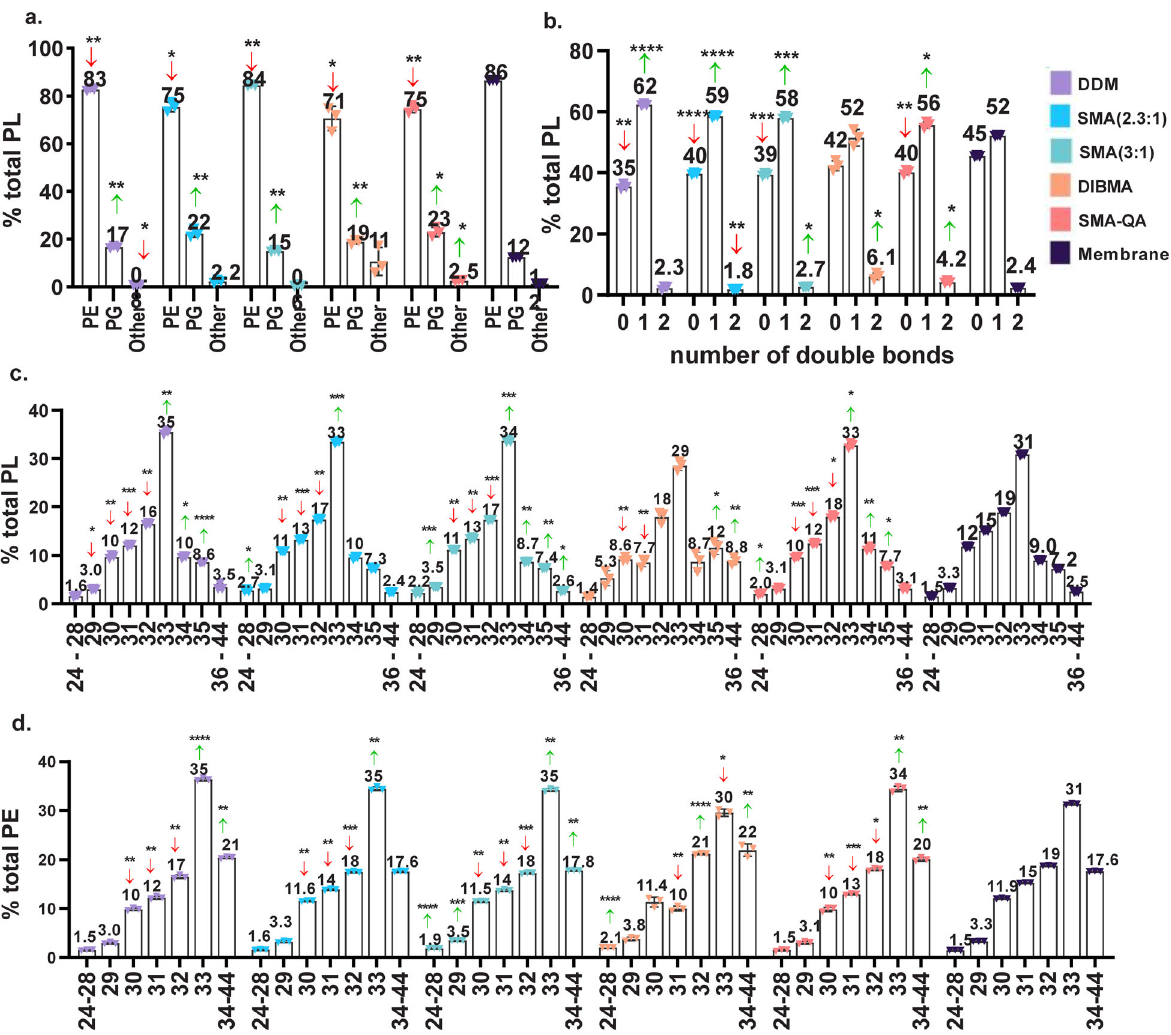
Fig. 3 PL content in solubilized and unaltered membrane of E. coli analyzed by LC-MS/MS. a E. coli headgroup distribution of PL species. The column “ other ” includes PS, PI and PA headgroups. b E. coli saturation of PL species. The number of double bonds indicated are those found in the total fatty acid chains of a single PL species. c E. coli distribution of carbon atoms present in fatty acid chains of the total PL species. d E. coli distribution of carbon atoms present in fatty acid chains of the total PE species. Data points correspond to three technical replicates. Error bars represent ±S.D. Signi fi cant differences (upon one-way ANOVA) are denoted as * p < 0.05, ** p < 0.01, *** p < 0.001, **** p <